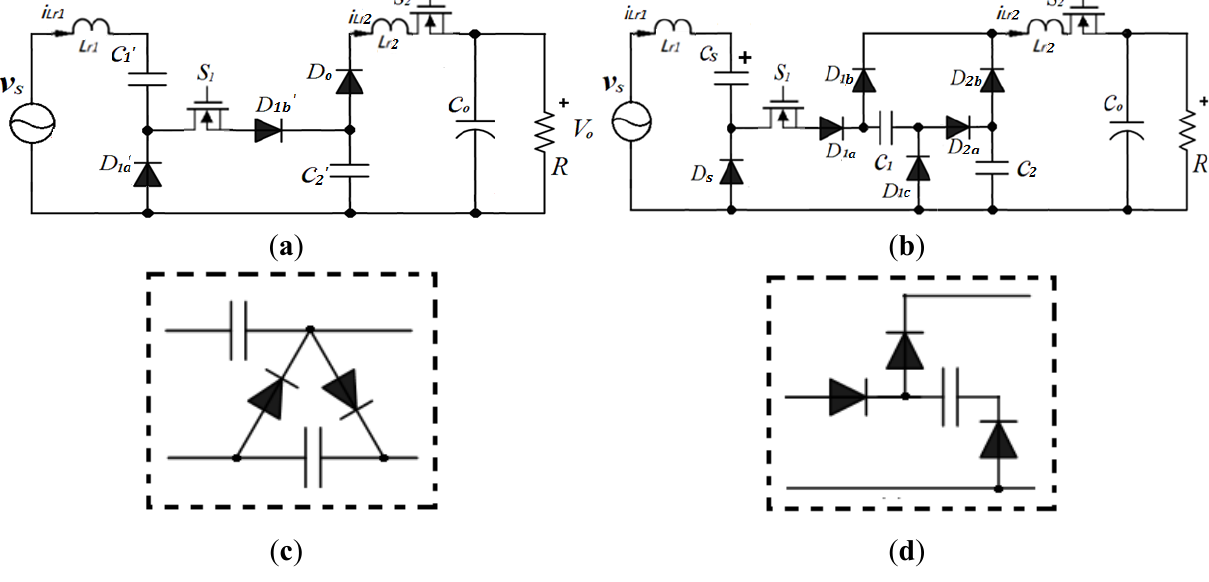
Figure 1. The basic step up and down circuit and switched capacitor cell for step up and step down: ( a ) basic step up version; ( b ) basic step down version; ( c ) step up cell [20]; and ( d ) step down cell